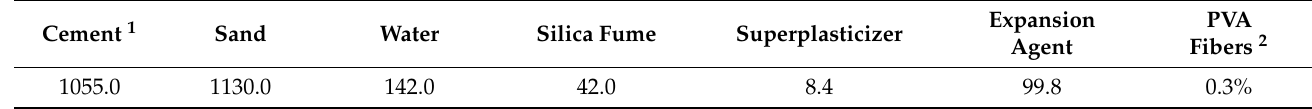
Table 2. Mixture composition of grout (Chemius Korea Ltd. Co., Seoul, Korea, unit: kg/m 3